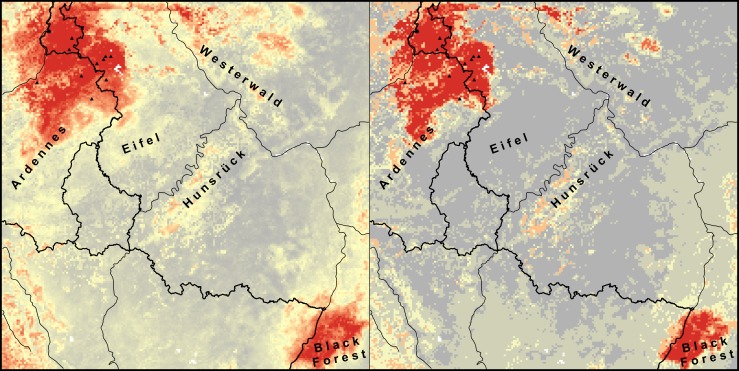
Average predictions of all Bsal SDMs.Average predicted suitability map (left) and presence-absence map (right) of all models. High values are indicated in red, low values in grey. Bsal presences are indicated by black triangles.